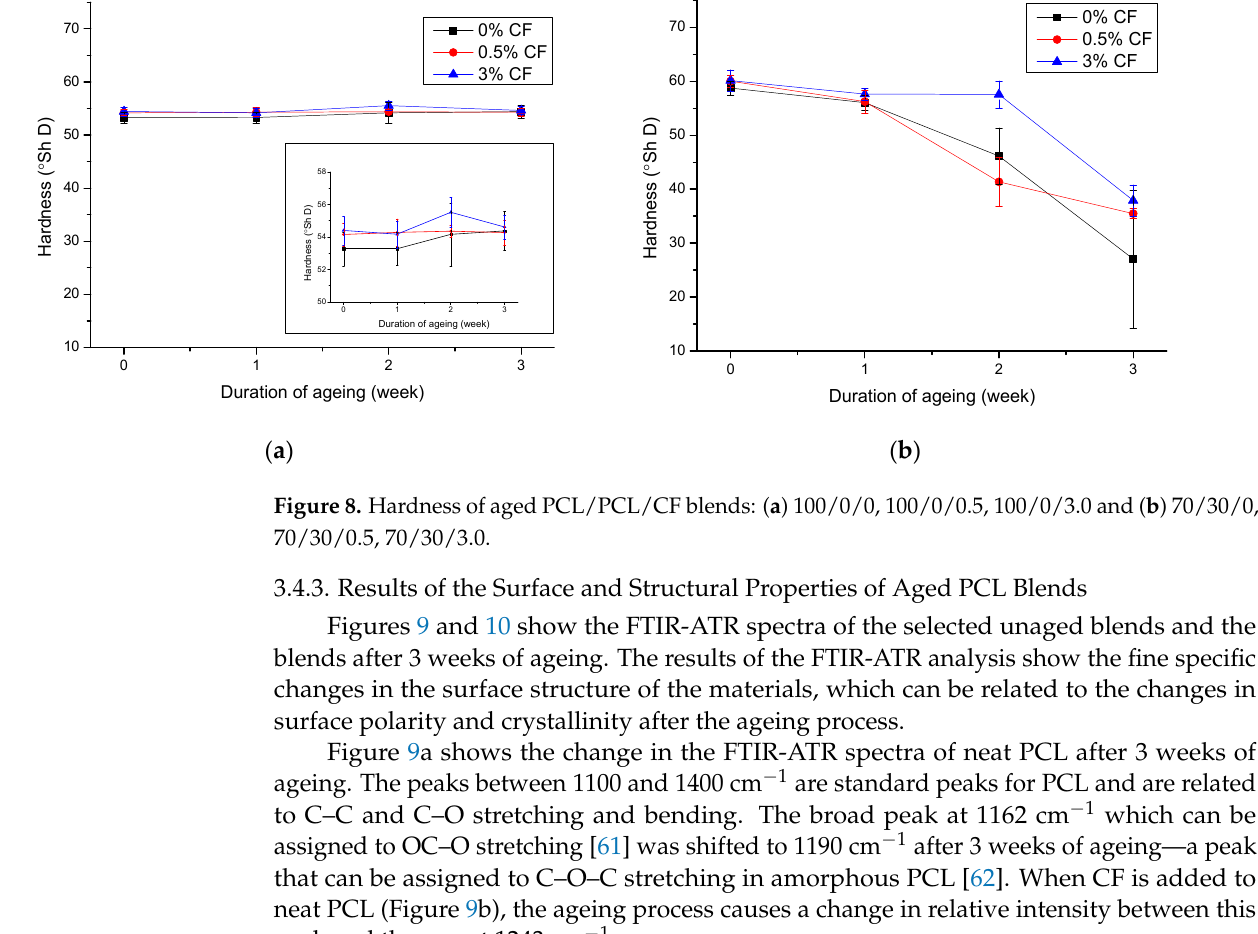
Figure 9. FTIR-ATR spectra of aged PCL/PLA/CF blends: ( a ) 100/0/0 and ( b ) 100/0/3.0.